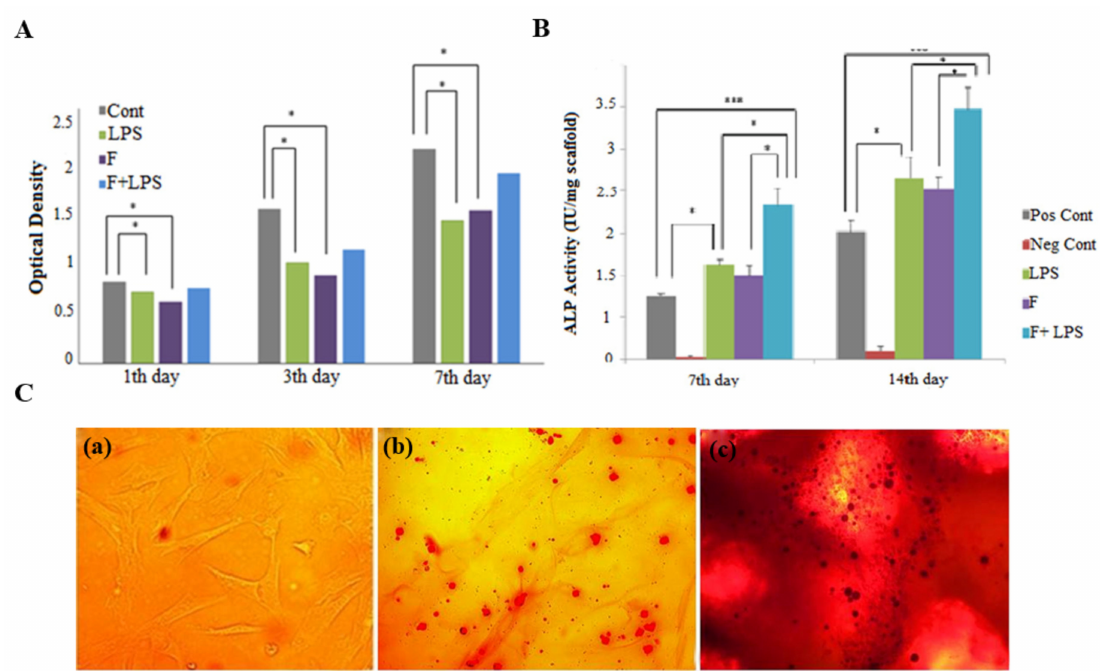
Figure 4. ( A ) Proliferation of MSCs on different scaffolds cultured for 7 days; ( B ) Alkaline phosphatase (ALP) activity in 2 weeks; ( C ) Alizarin red staining of MSCs on different scaffolds cultured in osteogenic culture medium for 14 days, * p ≤ 0.05, *** p ≤ 0.001. Reproduced with permission from [97]. Copyright Wiley